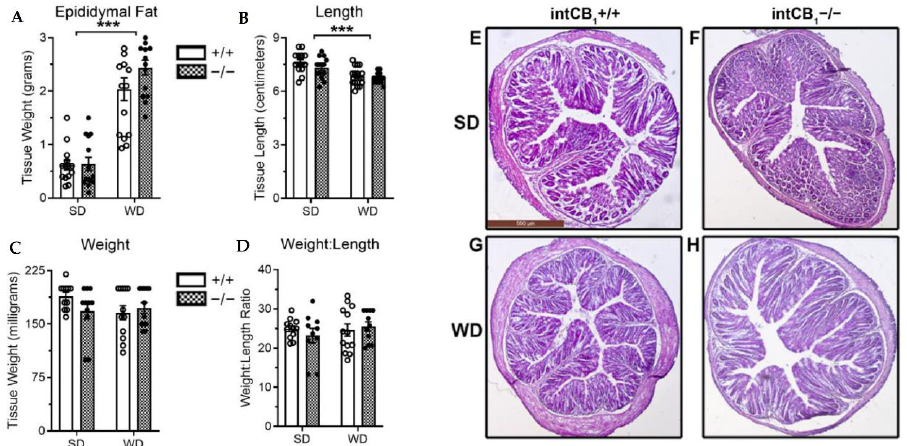
Figure 4. Effects of genotype and diet on epididymal fat mass, and large intestine length and weight. Mice fed WD for eight weeks displayed significant increases in epididymal fat mass ( A ) and significant decreases in colon length ( B ) regardless of genotype. However, no changes in colon weight or weight:length ratio were observed across diet or genotype ( C , D ). No significant alterations were observed in tissue architecture in representative 4 × images of 5 µ m thick colon slices ( E – H ). Epididymal fat data analyzed via two-way ordinary ANOVA with an effect of